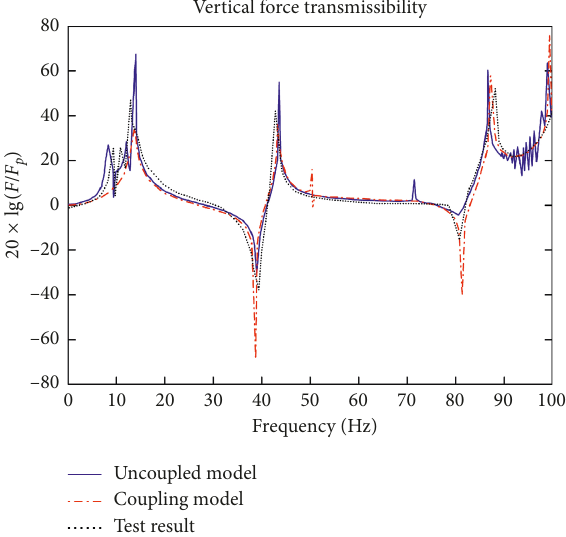
Figure 16: Vertical force transmissibility.